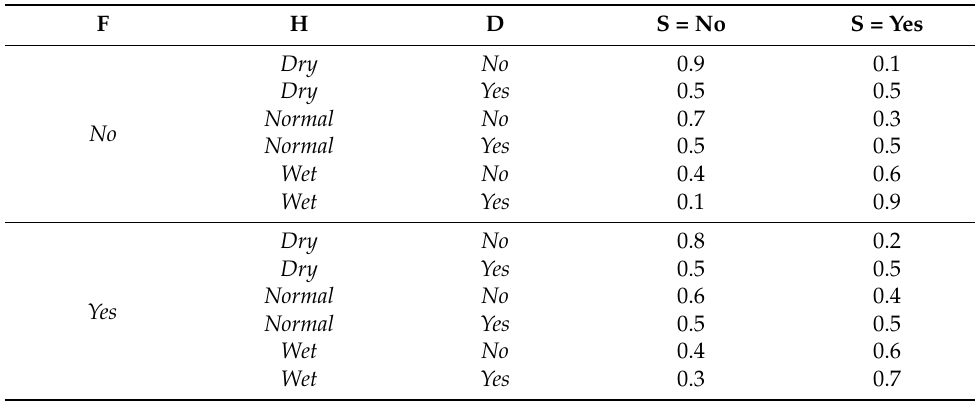
Table 3. Conditional Probability P( S|F, D, H )